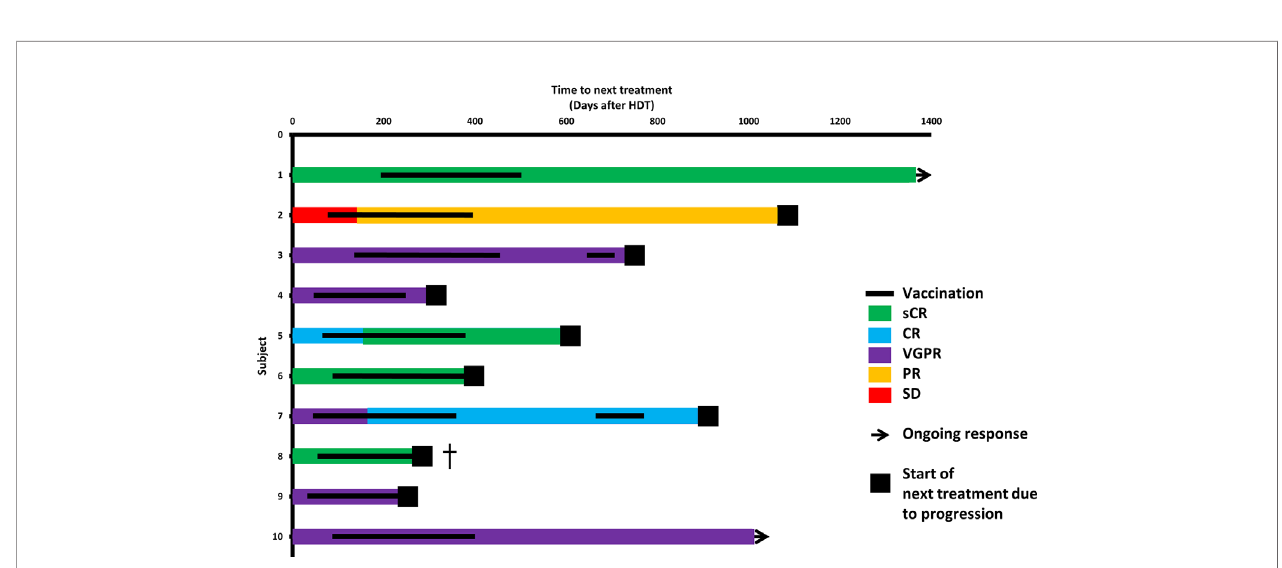
FIGURE 4 | Clinical course. Swimmer ’ s plot. Colors of bars symbolize depth of response at start of vaccinations, after HDT and during the vaccination course. † patient 8 had a rapid relapse after having received 11 vaccinations and died shortly thereafter despite initiation of